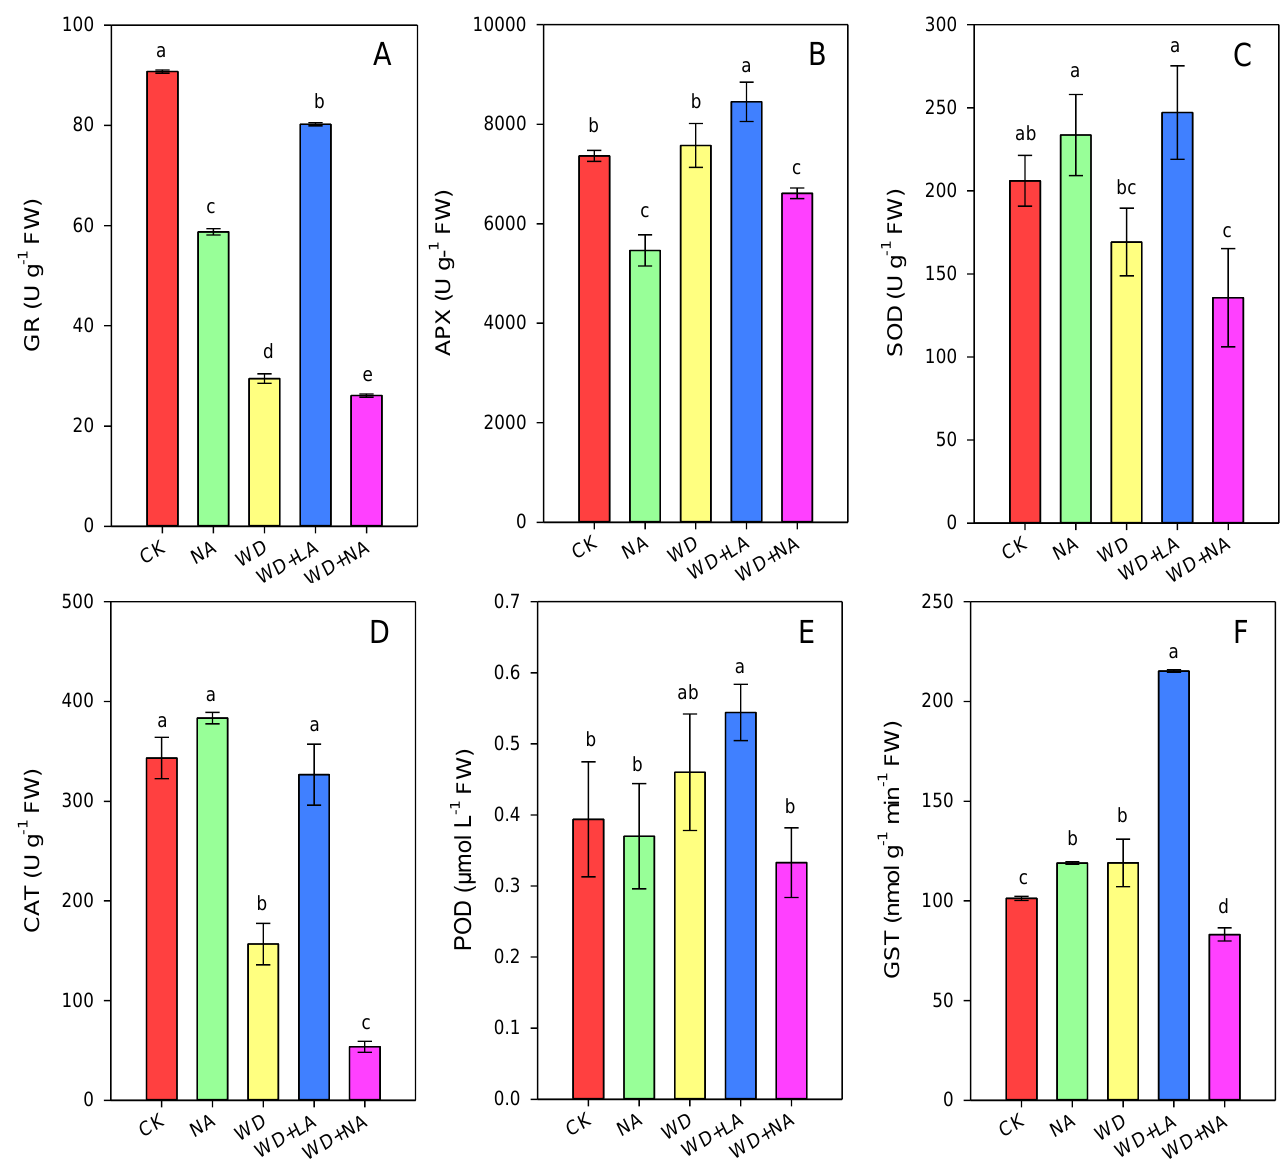
Figure 6. Effects of L-arginine and drought on the antioxidant enzyme activities of glutathione reductase (GR) ( A ), ascorbate peroxidase (APX) ( B ), superoxide dismutase (SOD) ( C ), catalase (CAT) ( D ), peroxidase (POD) ( E ), and glutathione-S-transferase (GST) ( F ) in maize seedlings under different treatments. CK: control treatment; NA: 25 μmol L – 1 of L-NAME; WD: 20% PEG; WD + LA: 20% PEG + 150 μmol L – 1 of L- arginine; WD + NA: 20% PEG + 25 μmol L – 1 of L-NAME. The results are presented as the means ± standard error ( n = 3). Significant differences are indicated by the lowercase letters ( p ≤ 0.05) based on the LSD test. Lowercase letters above the error bars in ( A – F ) indicate significant differences among the five treatments ( p < 0.05). L-NAME, N γ -nitro-L-arginine methyl ester; LSD, least significant difference.